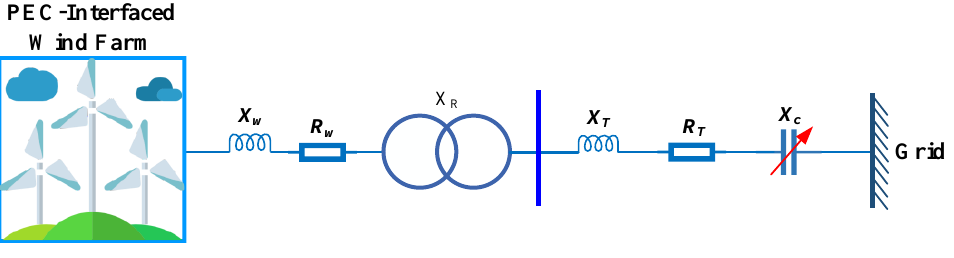
Figure 11. Wind farm connected to a series compensated line.